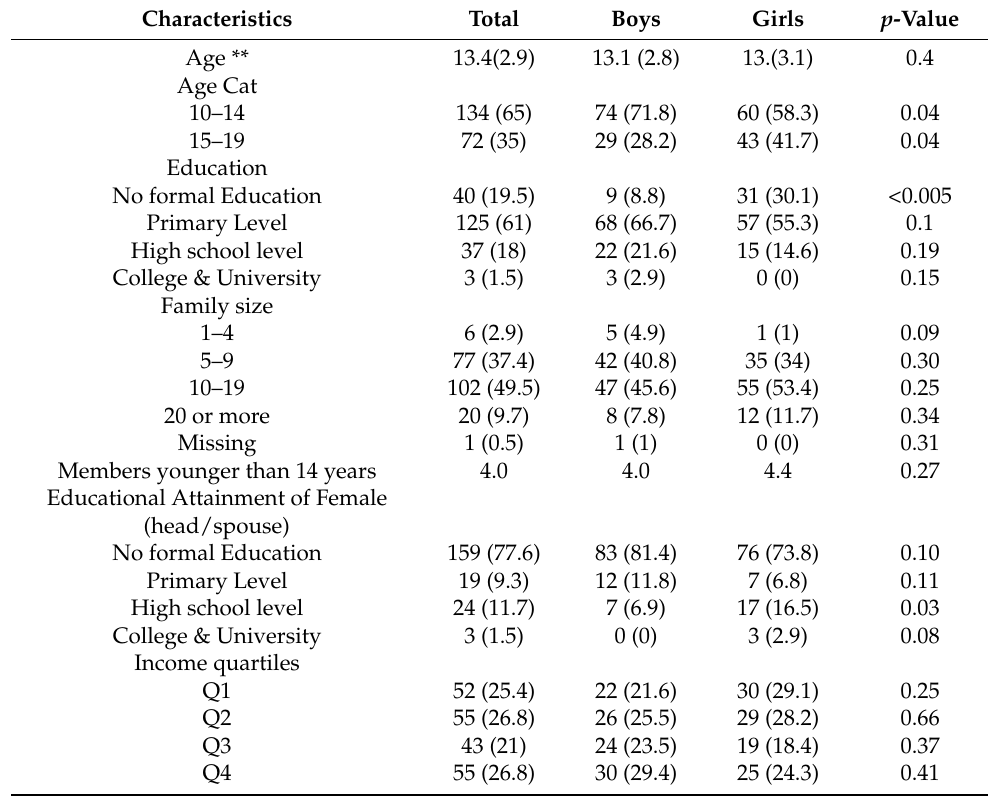
Table 1. Demographic and socio-economic characteristics of the study participants *.